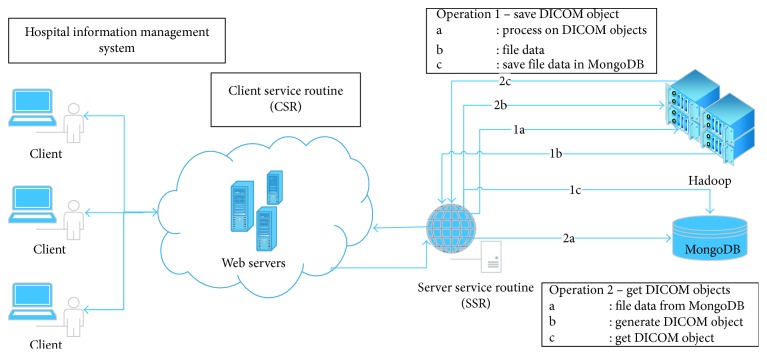
System overview.